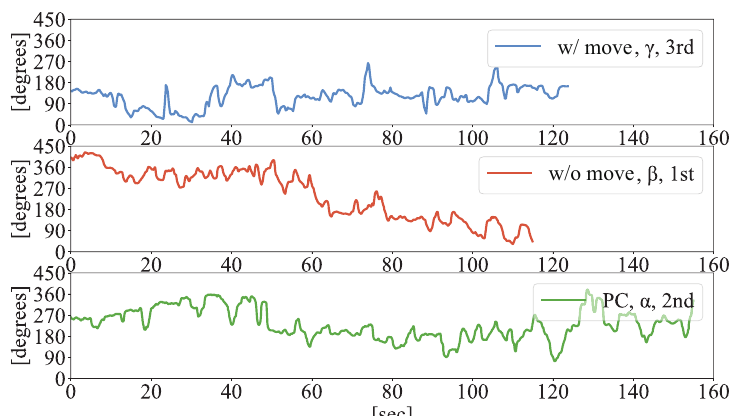
Figure 14. Raw yaw-axis data (P-C).